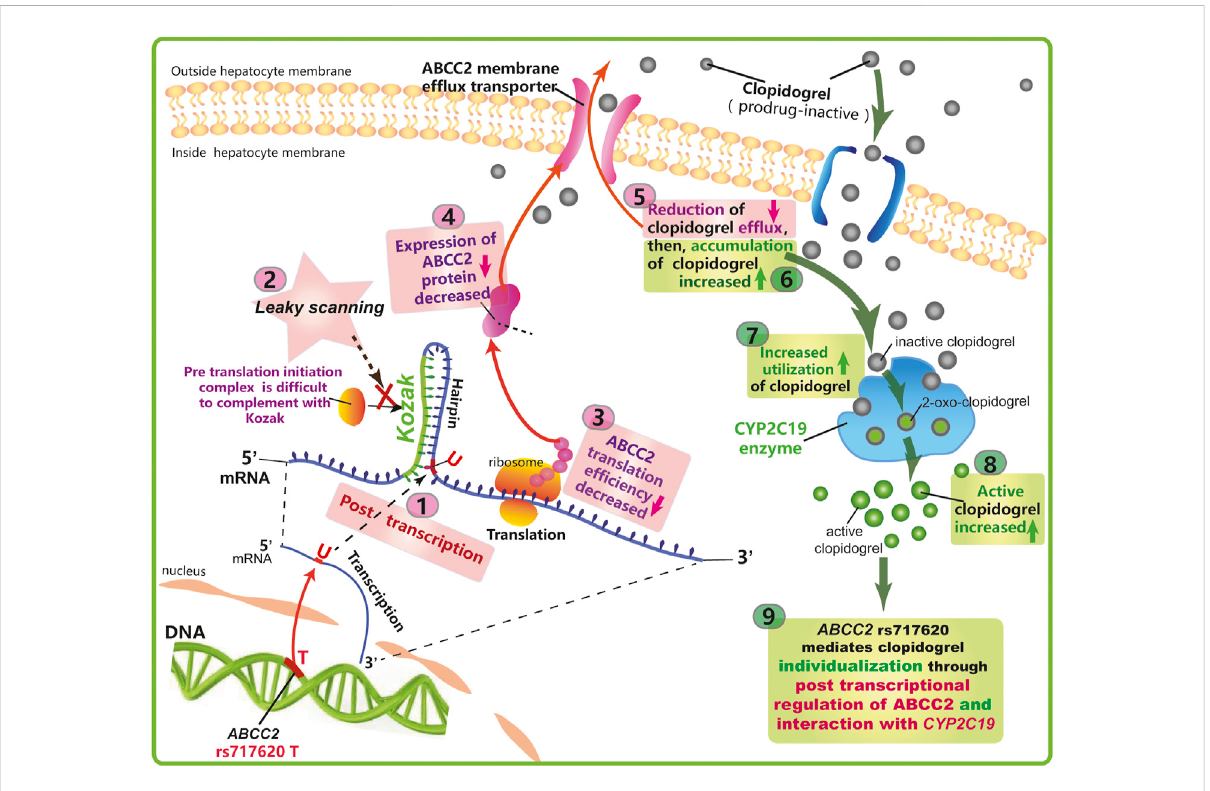
FIGURE 4 Proposed mechanism underlying the effect of ABCC2 rs717620 on the differential regulation of